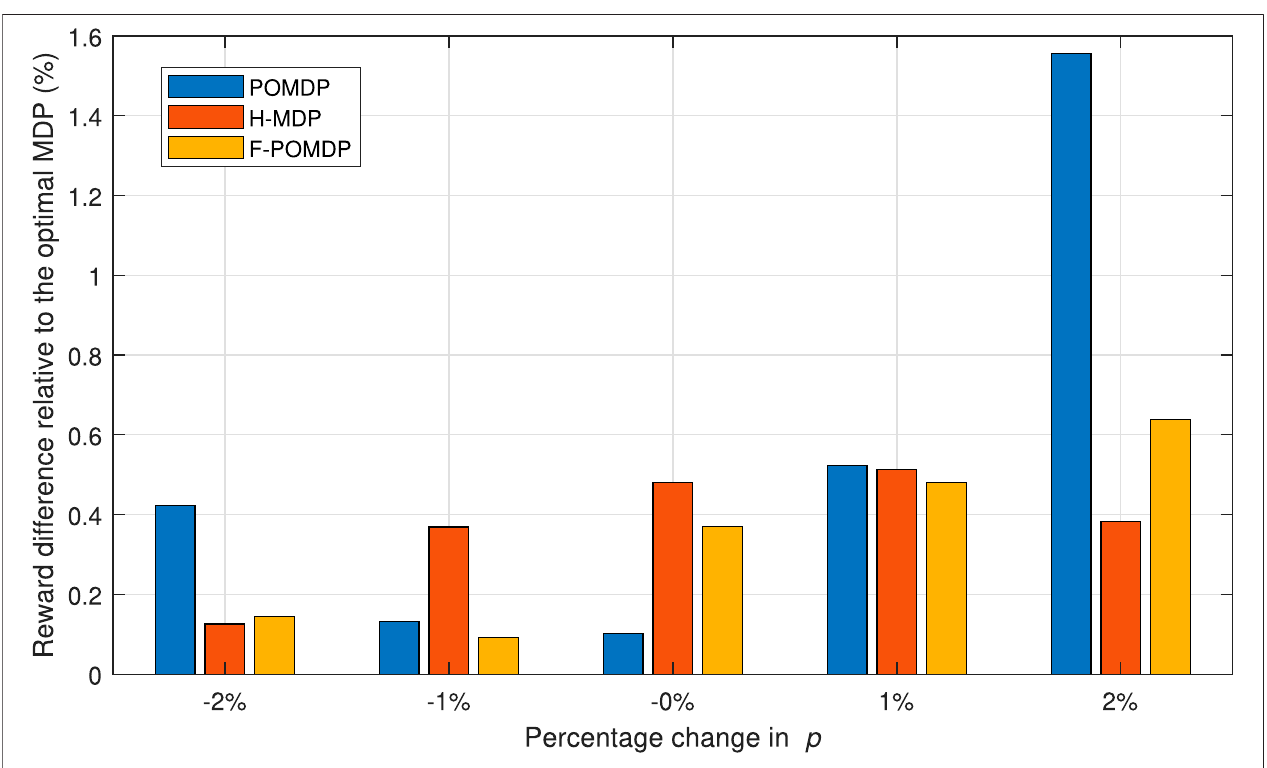
FIGURE 11 | System rewards with regard to the optimal MDP policy of full observability when having an error in estimating the p and r values, for the case of η (cid:2) 0.07.